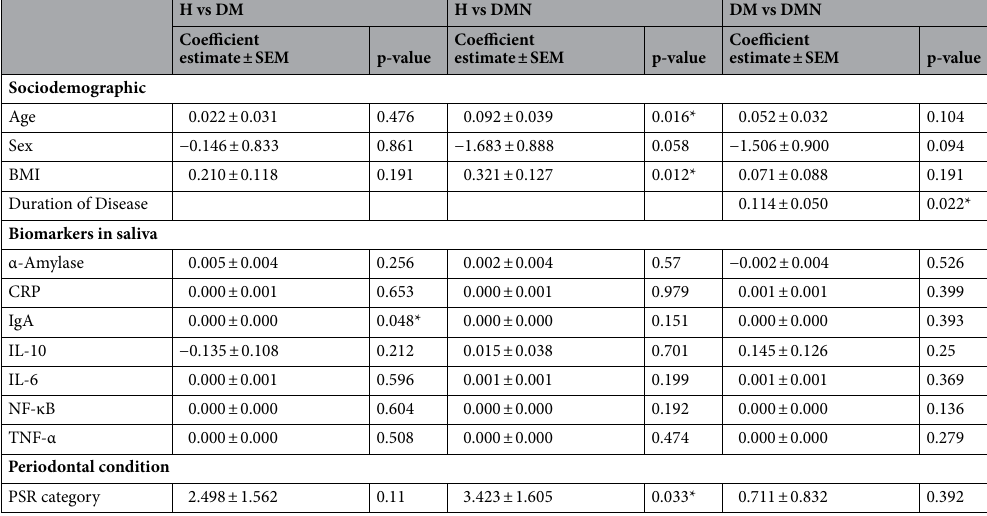
Table 2. Predictors analysis with the Bayes Logistic Regression. Each row indicates the predictor of the binary response, given by each column (e.g. healthy vs diabetes), using a logistic regression model. *p < 0.05.